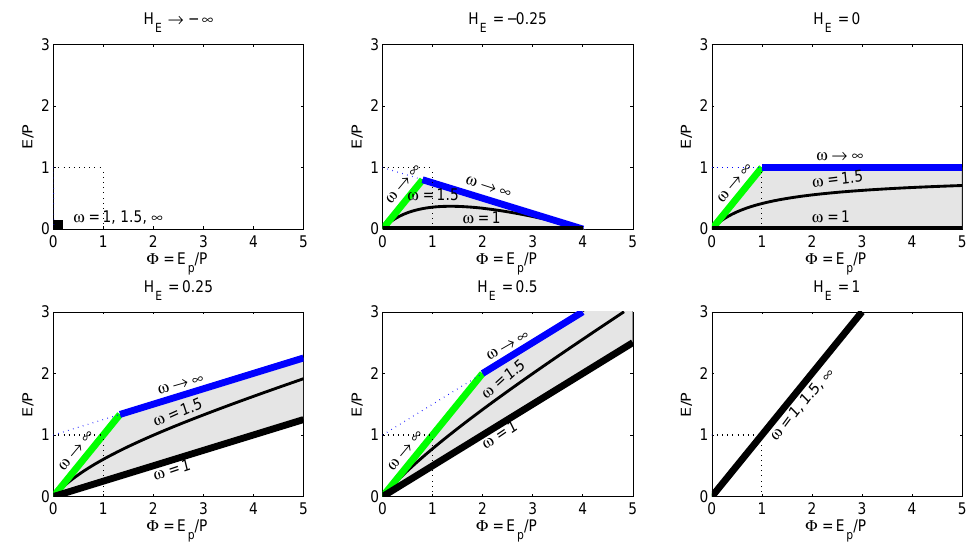
Figure 3. The ML formulation in the Budyko space with the Fu–Zhang relationship Eq. (14a, b) for ω = 1.5 and for different values of H E . The bold lines indicate the upper and lower limits of the feasible domain of evaporation (shown in grey).